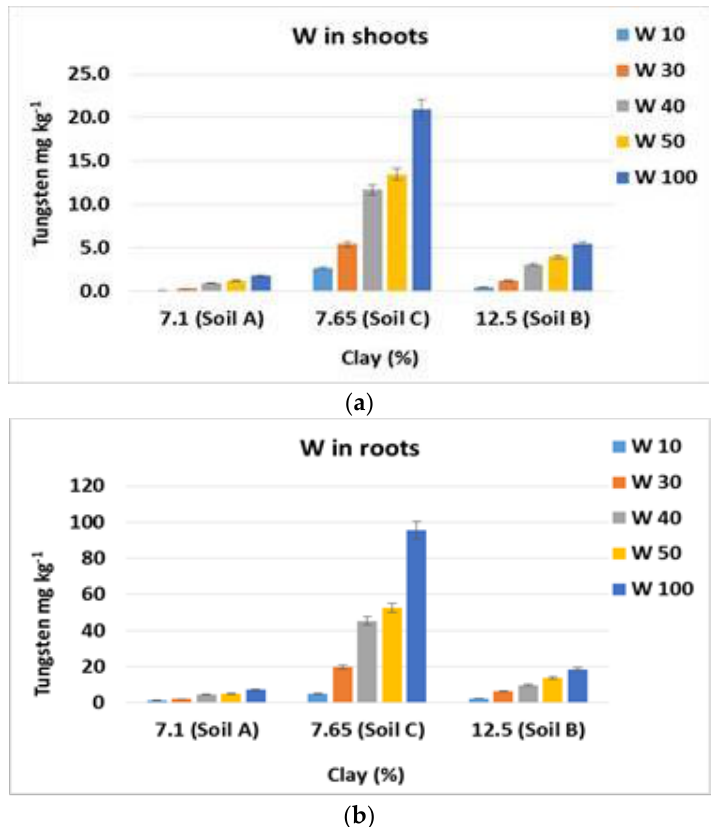
Figure 4. Mean values of tungsten concentrations in plants in relation to clay content of the different soils. Bars indicate standard deviation. ( a ) shoots; ( b ) roots.